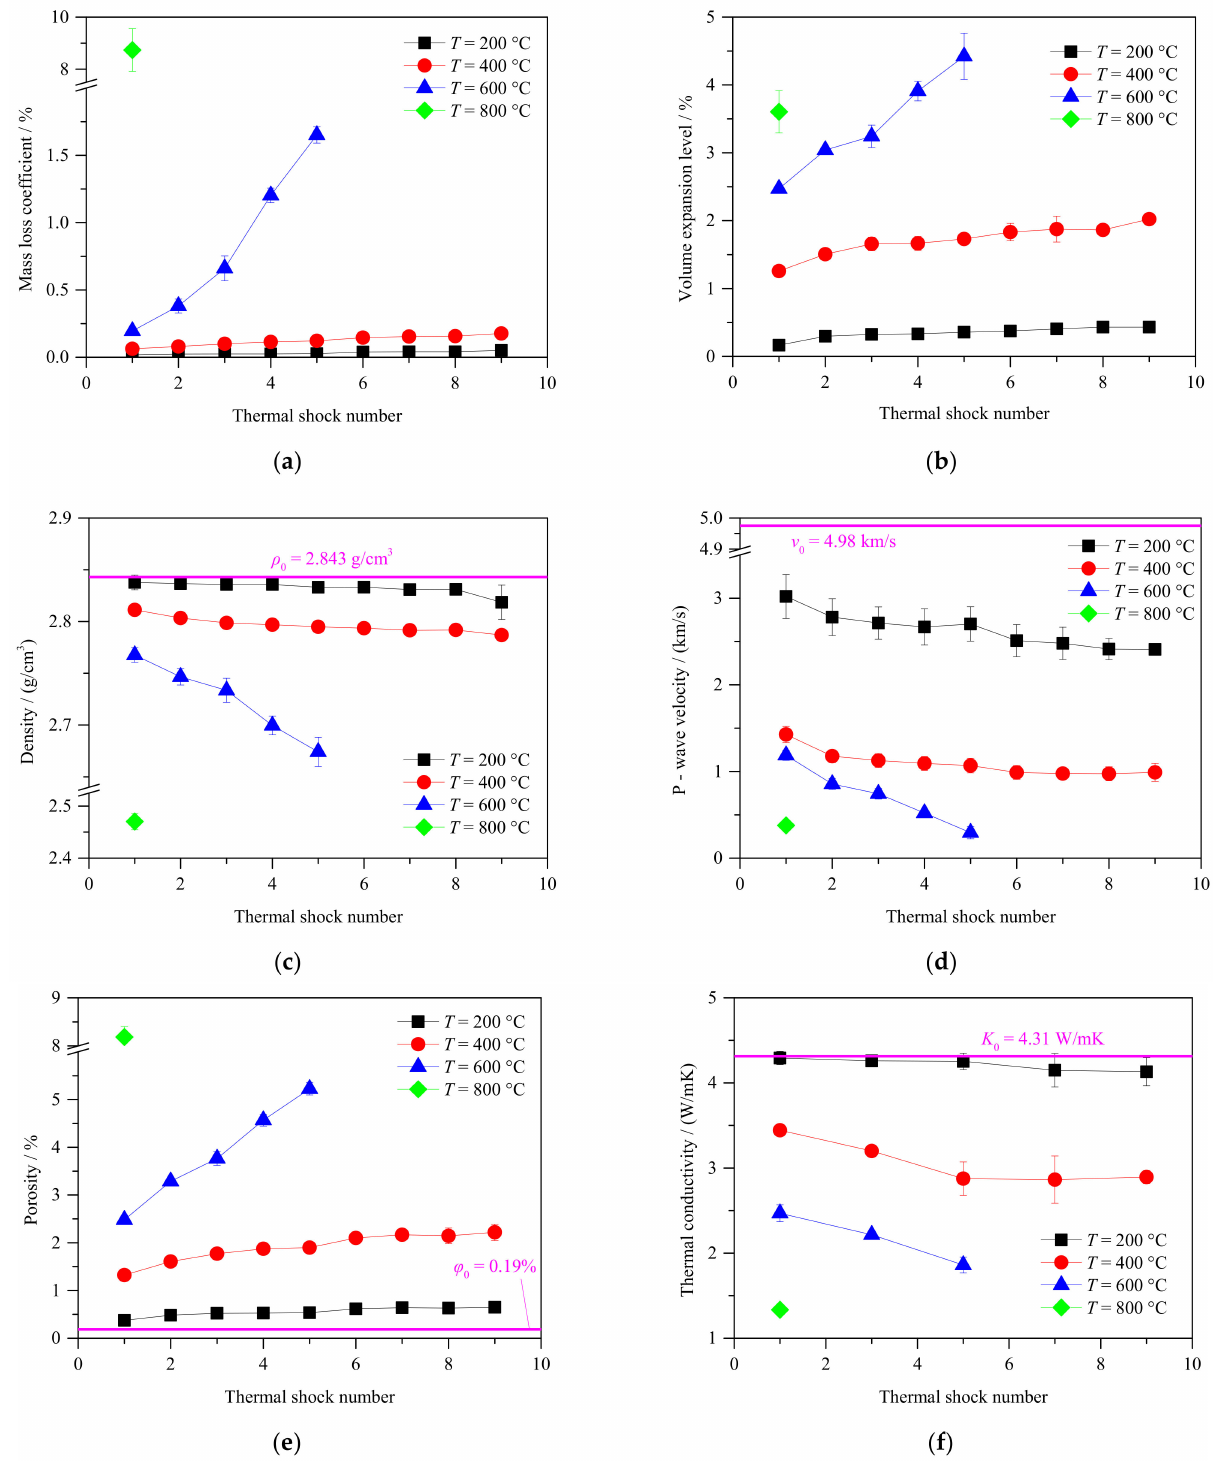
Figure 4. Effect of thermal shock numbers on the ( a ) mass loss coefficient, ( b ) volume expansion level, ( c ) density, ( d ) P-wave velocity, ( e ) porosity and ( f ) thermal conductivity (The error bar represents the standard